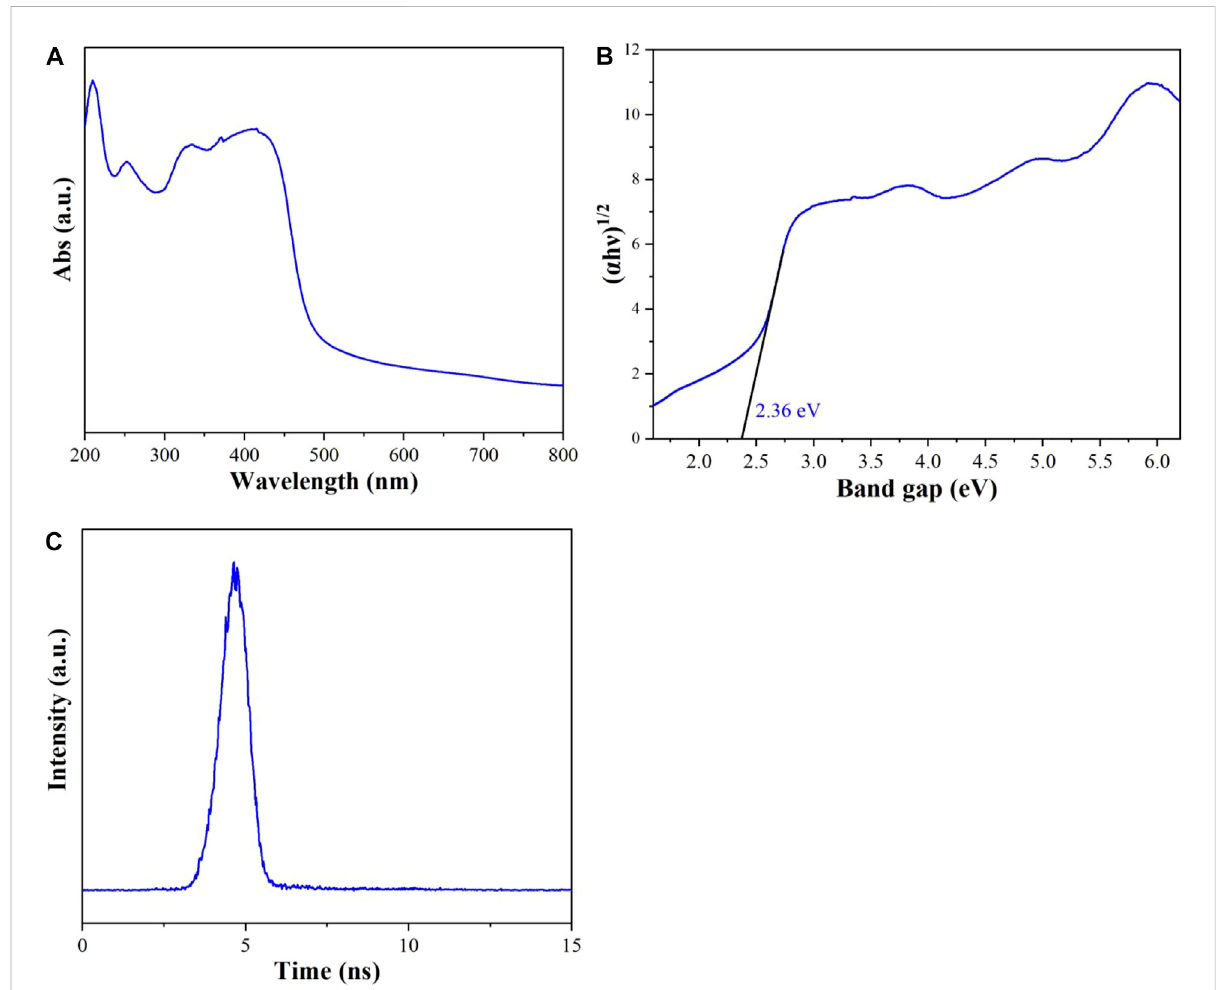
BET-BJH As can be seen from Figure 7A, the N 2 adsorption- desorption isotherm of Cu I MOF exhibits typical IV isotherms with H3 type hysteresis loop, which indicates the existence of mesopores. The pore size distribution curve further demonstrates the existence of mesopores (Figure 7B). The speci fi c surface area, corresponding pore volume and average pore diameter are 116.98 m 2 g − 1 , 0.77 cm 3 g − 1 and 26.40 nm respectively. The high speci fi c surface area and large pore volume could provide more active sites for the reactant adsorption and photocatalytic reaction, which is in agreement with SEM